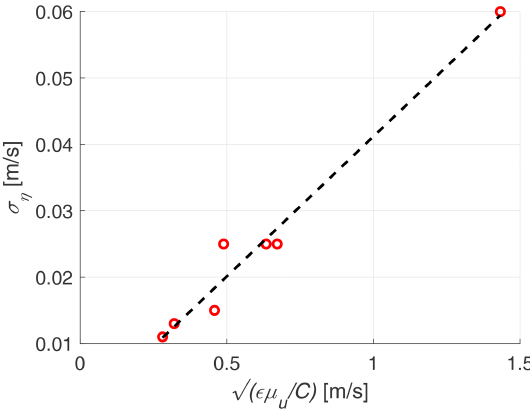
Figure B1. Plot of the relationship between the lidar spectral noise standard deviation σ η and the square root of the energy dissipation rate multiplied by the mean wind